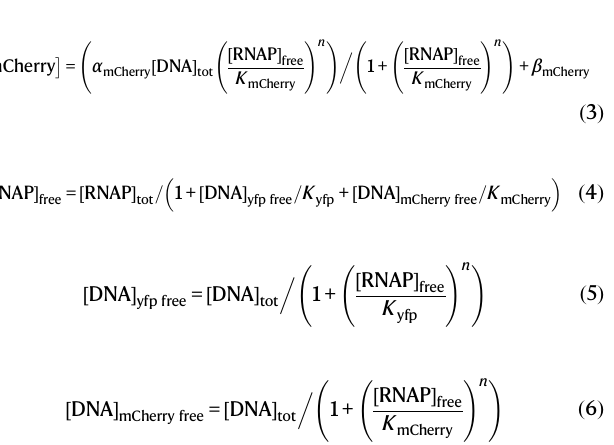
Fig. 2 | Resource competition model in the two-reporter system. a The genetic circuit design for the RNAP-driven expression of two reporter genes. b Characterization of resource competition by two co-expressed reporters in HEK293T. Experimental data and model predictions are compared at varying activities for the two reporters. Data represent mean values of more than three